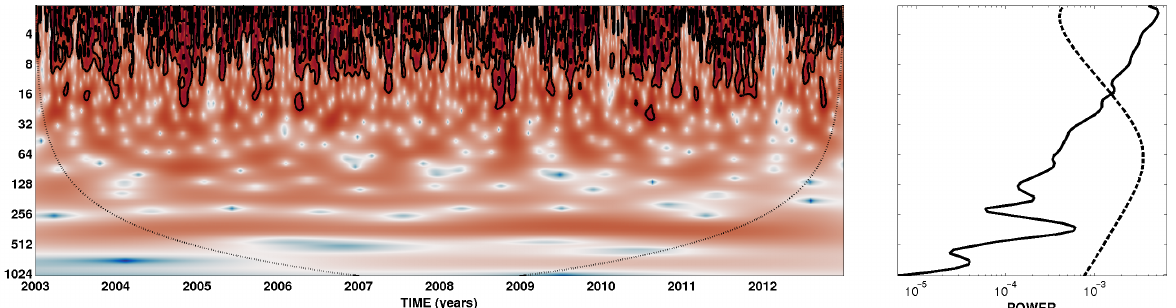
Figure 5. ( Left panel ) Local wavelet power spectrum for the time series of power converted at SP site using Morlet wavelet. Thick contour lines enclose regions of greater than 95% confidence for a red-noise process with a lag-1 coefficient of 0.90. Cross-hatched regions indicate the cone of influence where edge effects become important. ( Right Panel ) Global wavelet power spectrum where values above tendency dashed line represent 95% of confidence. The dotted lines represent the cone of influence and inside it are the regions where effects become important (for interpretation of color in this Figure, the reader is referred to the web version of the